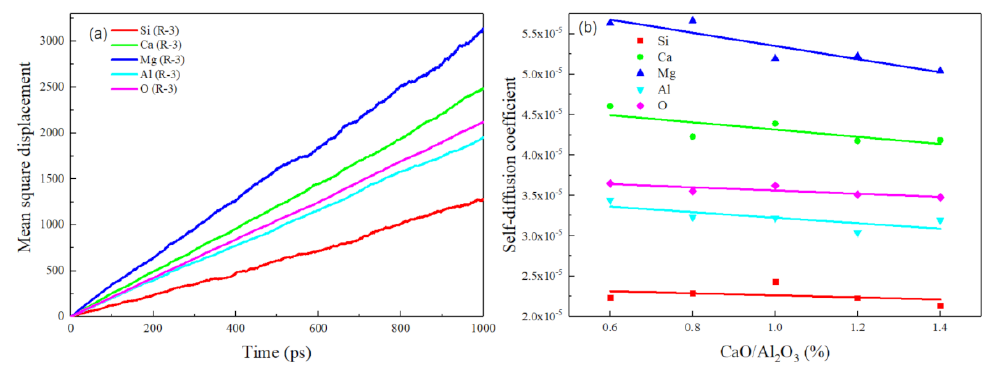
Figure 10. Variation of ( a ) mean square distribution and ( b ) self-diffusion coefficients of different atoms with various CaO/Al 2 O 3